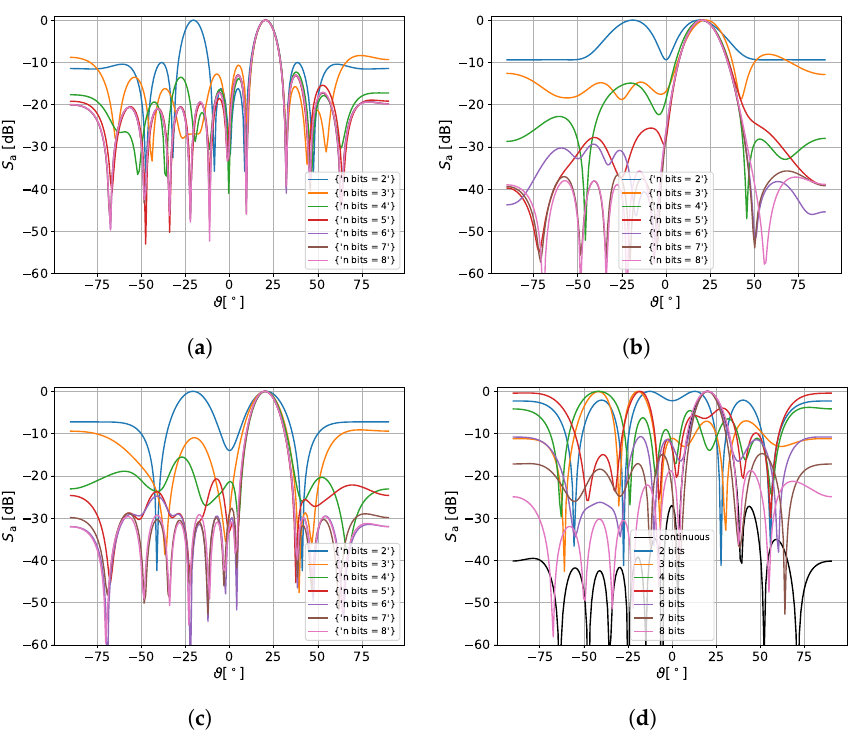
Figure 7. The influence of quantization of coefficients. ( a ) Fourier method with rectangular window; ( b ) Fourier method with Hamming window; ( c ) Dolph–Chebychev method with required side lobe level − 30 dB; and ( d ) Schelkunoff’s zero-placement